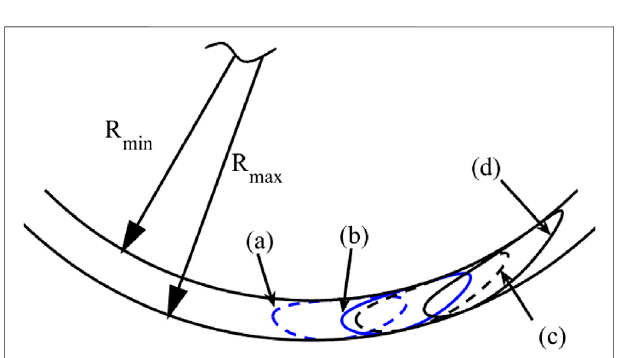
FIGURE 5 | Different paths generated by the adjustable slider-crank mechanism.